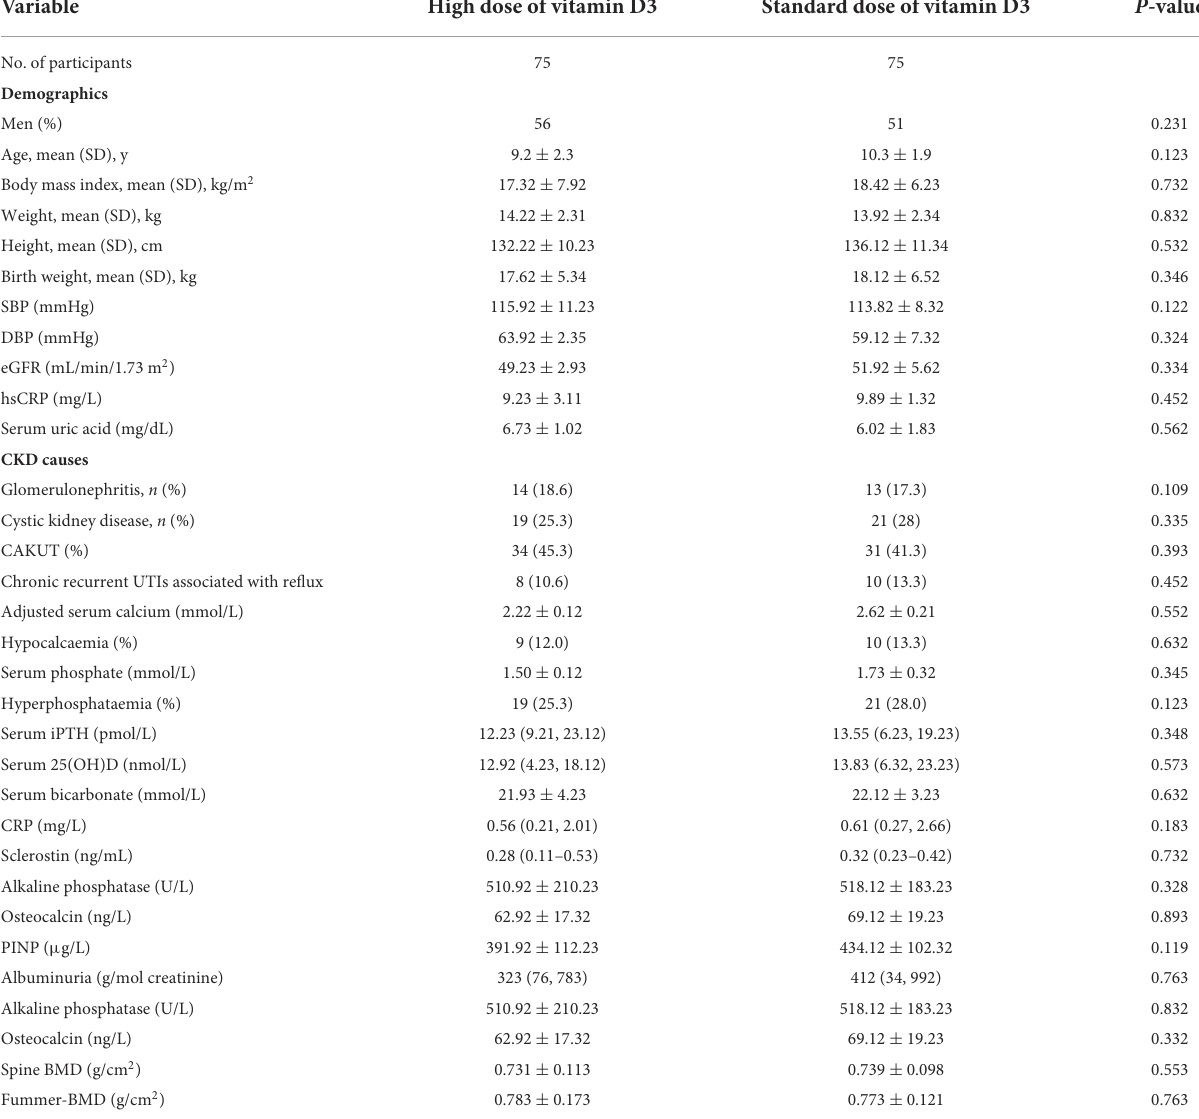
TABLE 1 Baseline demographic, health characteristic, and laboratory values